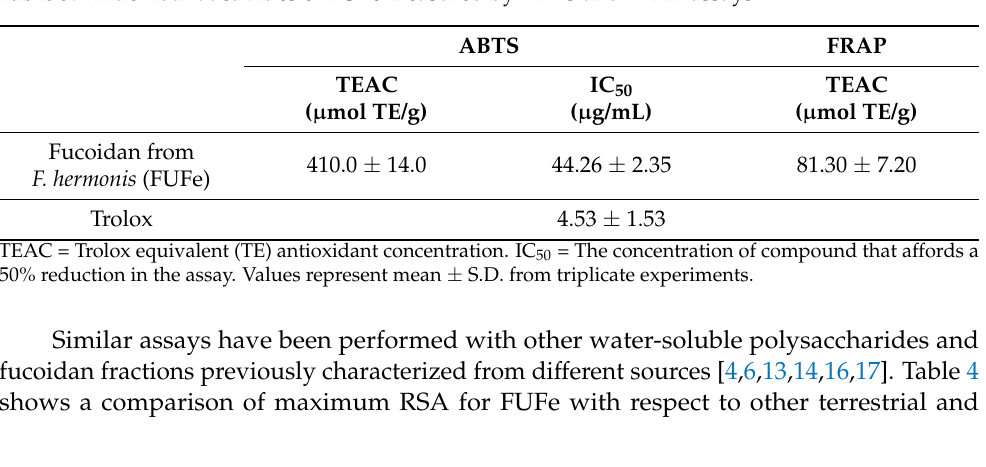
Table 3. Antioxidant activities of FUFe measured by ABTS and FRAP